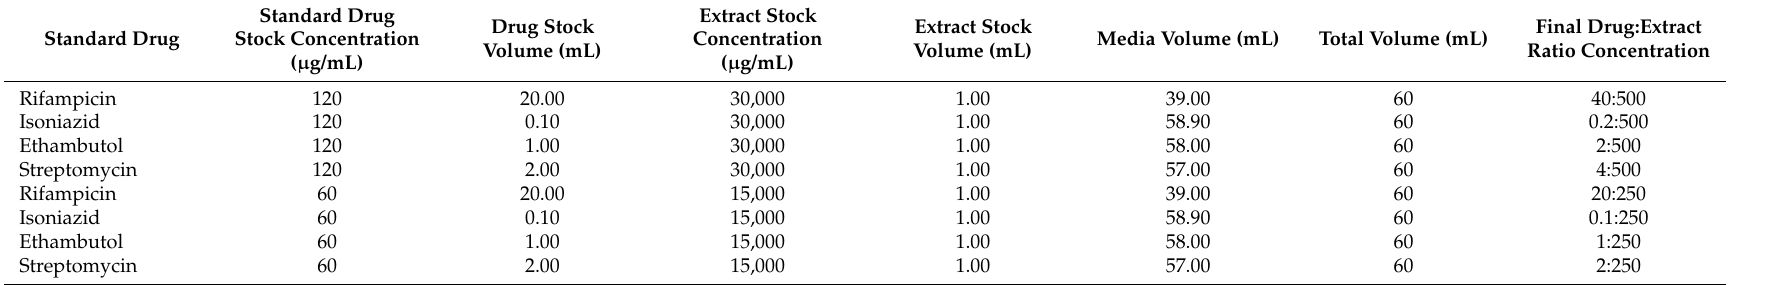
Table 2. Summary of the preparation to make the Kaempferia galanga combination with standard antituberculosis